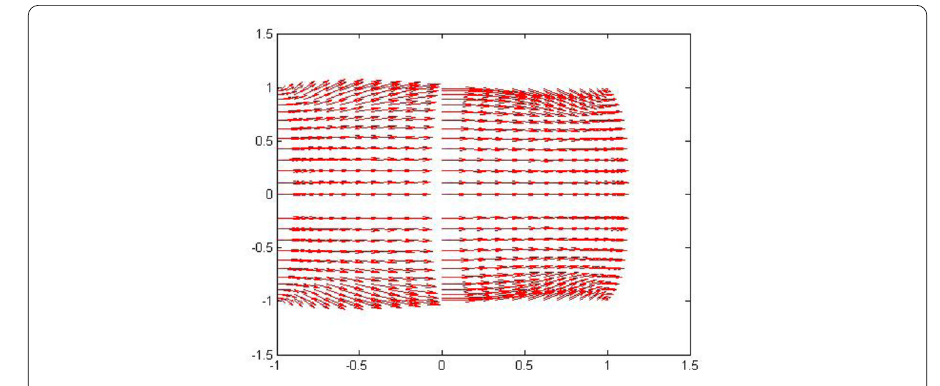
Figure 3 The vector field of the velocity for f = (0,0) and g defined in (16)